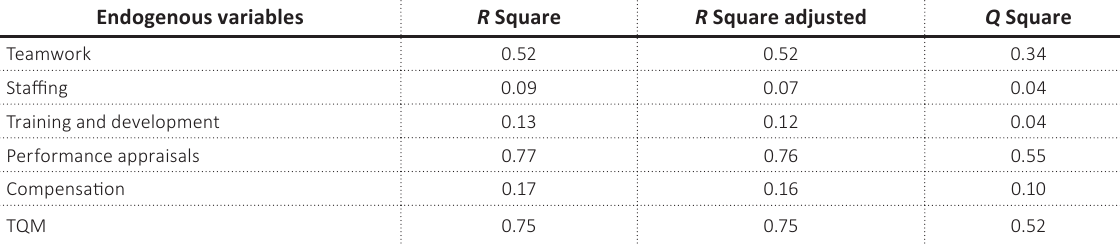
Table 6. Predictive